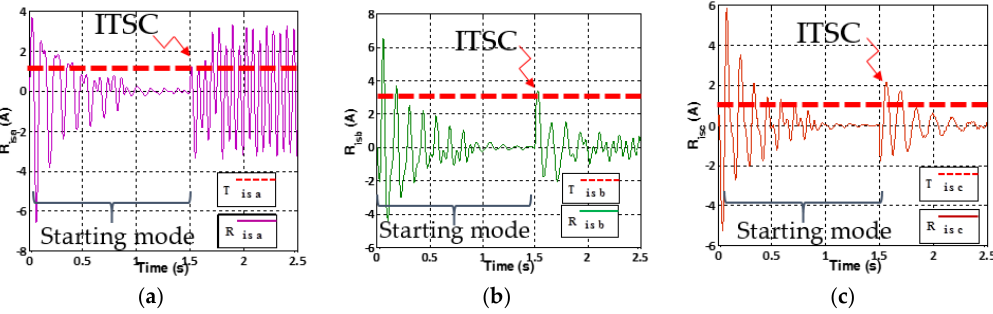
Figure 6. Simulation results of ( a ) residual Ris a and its threshold Tis a ; ( b ) residual Ris b and its threshold Tis b ; and ( c ) residual Ris c and its threshold Tis c of wind turbine IG with ITSC fault of 30% of s 1 -phase at t = 1.5 s.